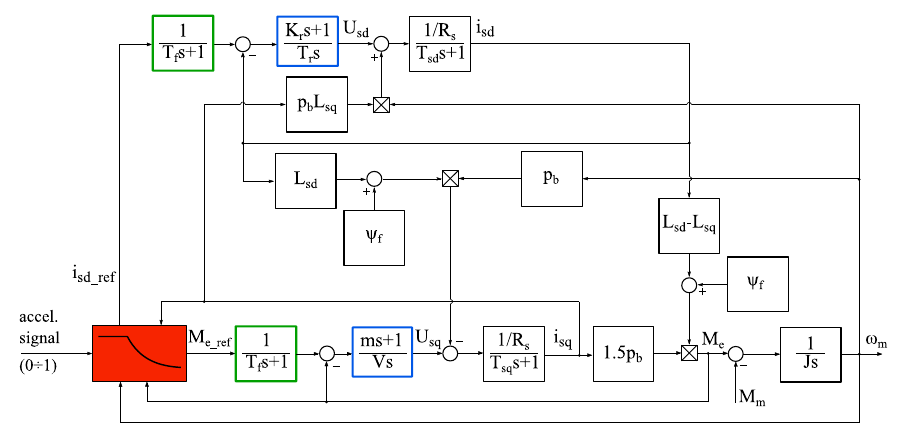
Figure 6. Schematic diagram of the PMSM control system in an EV application.